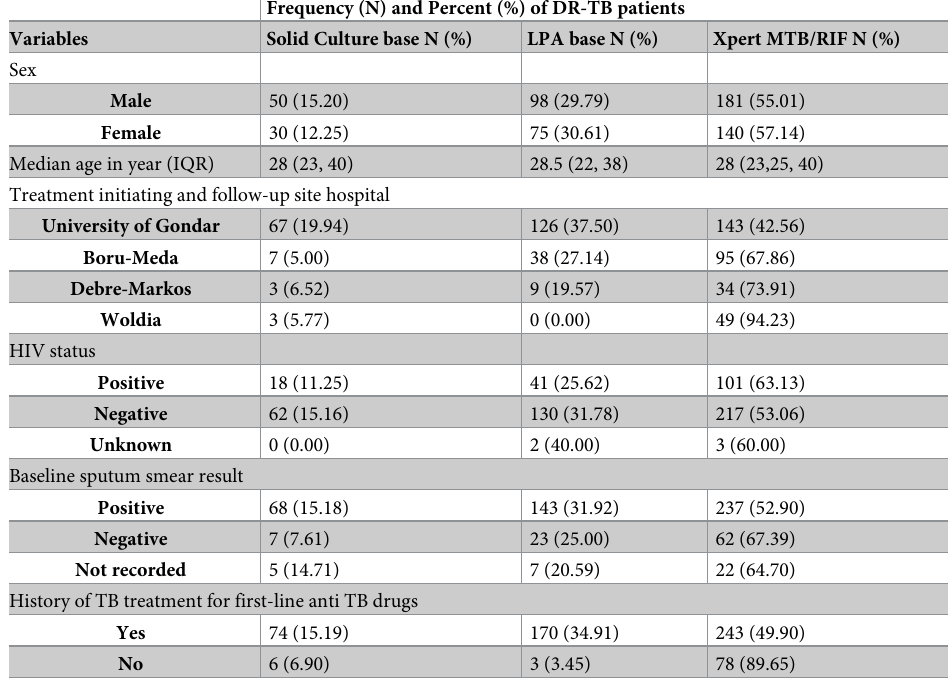
Table 1. Demographic and clinical characteristics of DR-TB patients stratified by the diagnostic methods in Amhara regional state, Ethiopia.